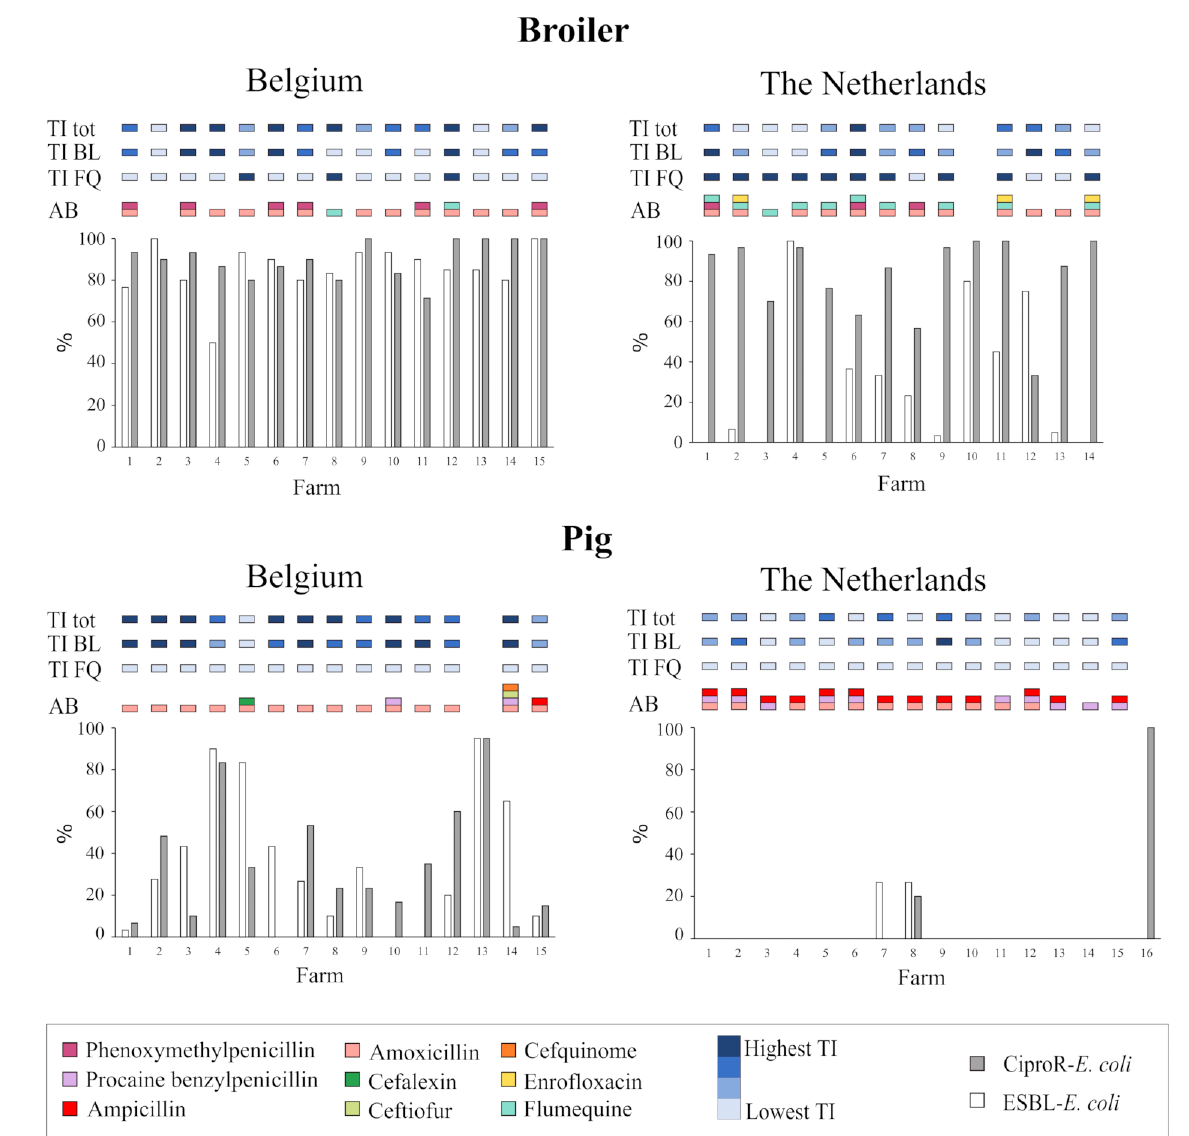
Figure 1. Percentages of ESBL- E. coli and CiproR- E. coli in Belgian and Dutch broiler and pig farms and the use of antibiotics at farm level. Antibiotic use in the year preceding sampling is presented as treatment incidence (TI) of total antibiotic use (TI tot), beta-lactam (TI BL) and fluoroquinolone (TI FQ) antibiotics. Colors indicate the active substance of the antibiotic (AB) used. Lowest to highest TI was indicated with a blue gradient. The total TI and beta-lactam TI was categorized based on quartiles. The TI of fluoroquinolones was categorized based on use or no use. For Dutch pig farm ID ten, eleven and twelve prevalence of ciprofloxacin-resistant E. coli was not determined. For Belgian pig farm ID 13 and Dutch pig farm ID 16, data on antibiotic use was not available for